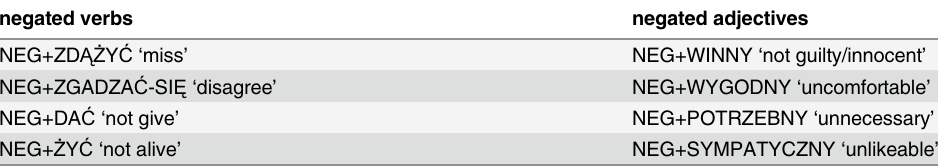
Table 1. Examples of prefixed PJM signs as negated verbs or